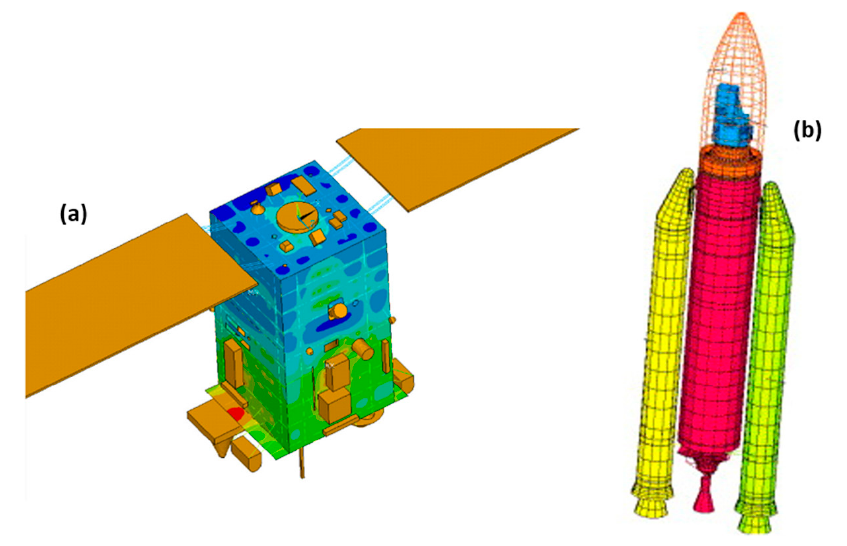
Figure 40. Some applications of FEM in composites in the space sector: ( a ) satellite. Reproduced with Creative Common License [269], and ( b ) coupled launcher–satellite structure. Reproduced with permission [295].